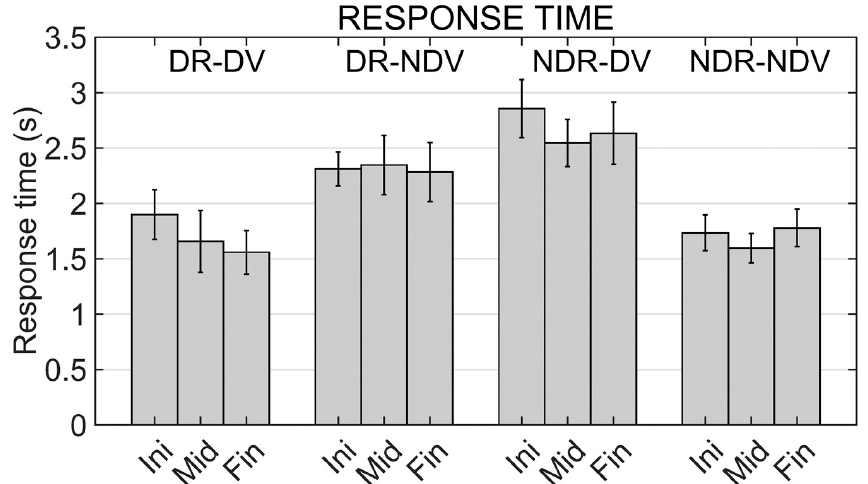
Figure 4. Response times in the different experimental conditions (DR_DV, DR_NDV, NDR_DV and NDR_NDV) and in the different moments of the training (Initial, Middle and Final moments). Mean values and standard errors of the mean are shown.